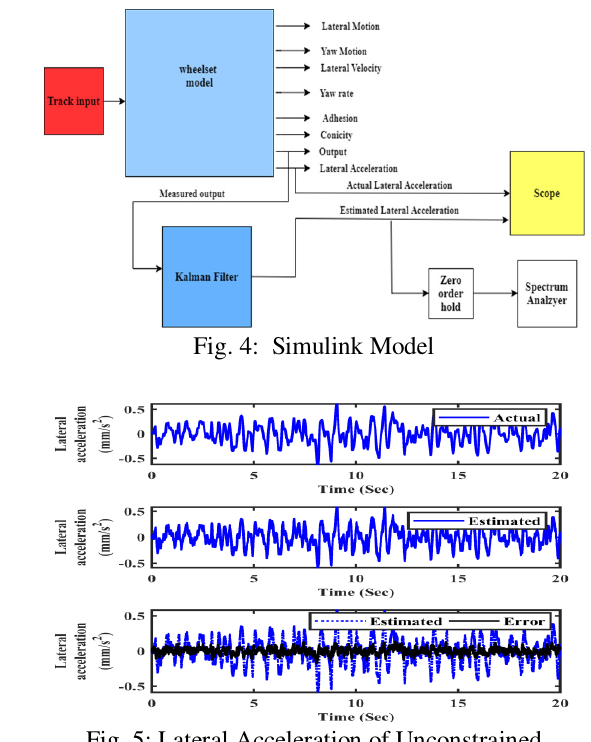
Fig. 5: Lateral Acceleration of Unconstrained Wheelset ( λ w = 0.05